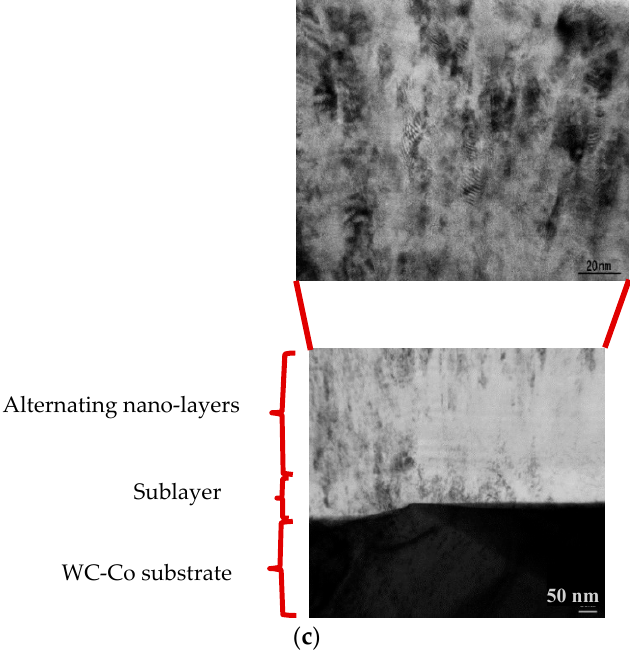
Figure 1. TEM (transmission electron microscope, JEOL FS2200, JEO USA, Inc., Peabody, MA, USA) image of FIB cross-section of TiAlCrSiYN-based coatings: ( a ) TiAlCrSiYN monolayer; ( b ) TiAlCrSiYN/TiAlCrN multilayer; ( c ) TiAlCrSiYN/TiAlCrN bi-multilayer. Thickness of alternating nano-layers in multilayered coatings is 20–40 nm, thickness of TiAlCrN sublayer is 100 nm.